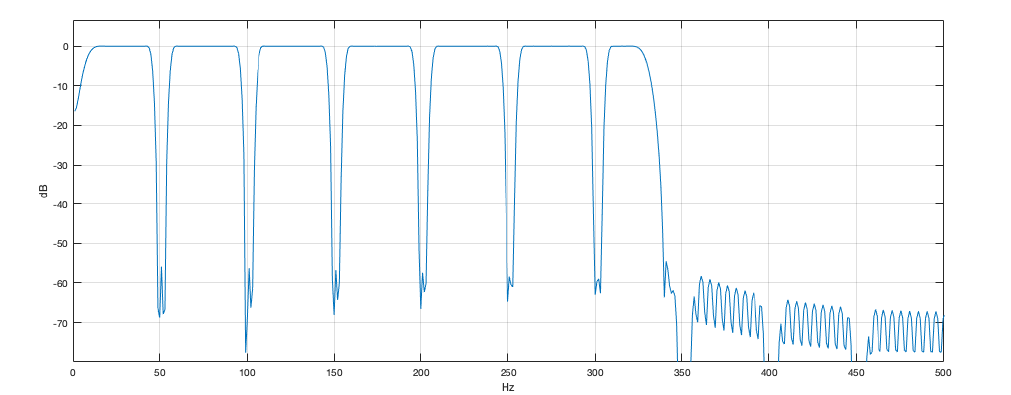
Figure 2. FIR filter used in the pre-processing